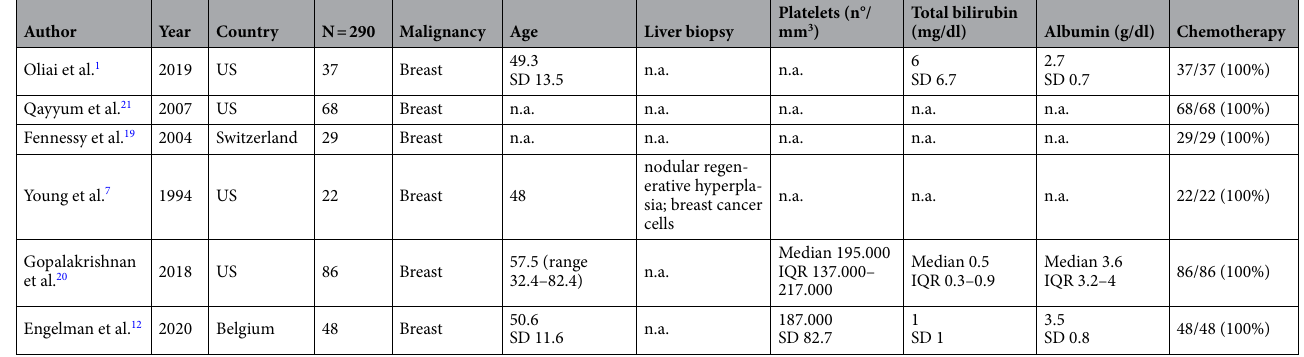
Table 3. Observational studies included in the final